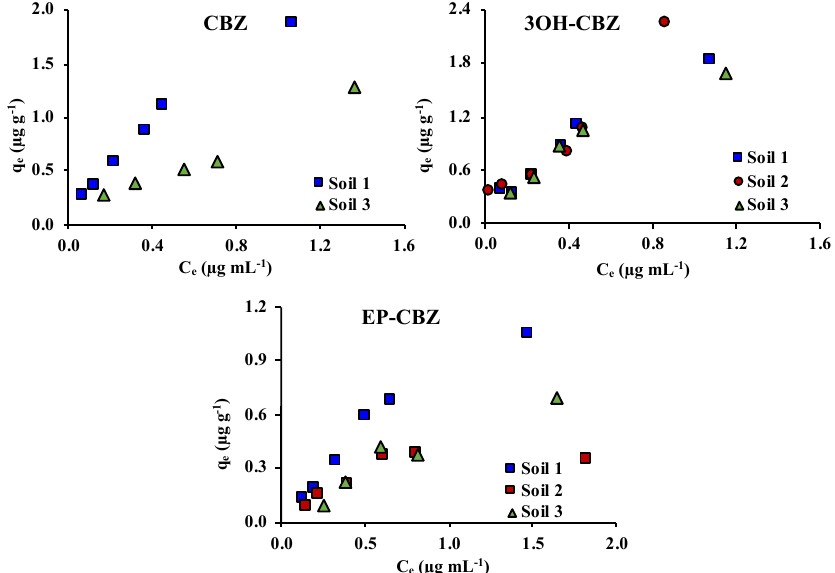
Figure 3. Adsorption curves for CBZ and its metabolites in studied soils in the four-solute systems; q e : amount of compound adsorbed; C e : concentration of compound in the equilibrium solution. A good fitting was obtained for all evaluated isotherms (R 2 values higher than 0.9100, 0.8947 and 0.8535 for Linear, Freundlich, and Langmuir isotherms models), except in the case of soil 2 for which low correlation coefficients were obtained in the case of Freundlich and Langmuir isotherms of 3OH- CBZ (0.7464 and 0.7501, respectively) and for linear and Freundlich isotherms (0.4900 and 0.8079, respectively) for EP-CBZ. CBZ was not adsorbed in soil 2 and 10OH-CBZ was not adsorbed in any of the studied soils.